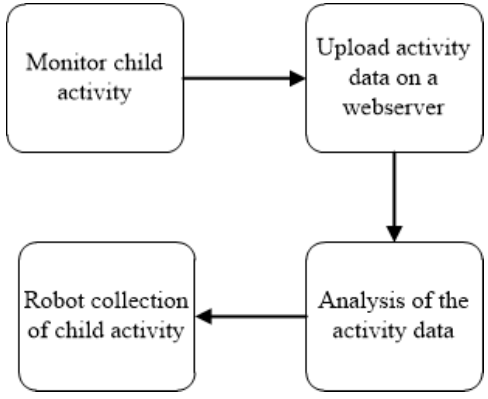
Figure 2. Obesity management functions.